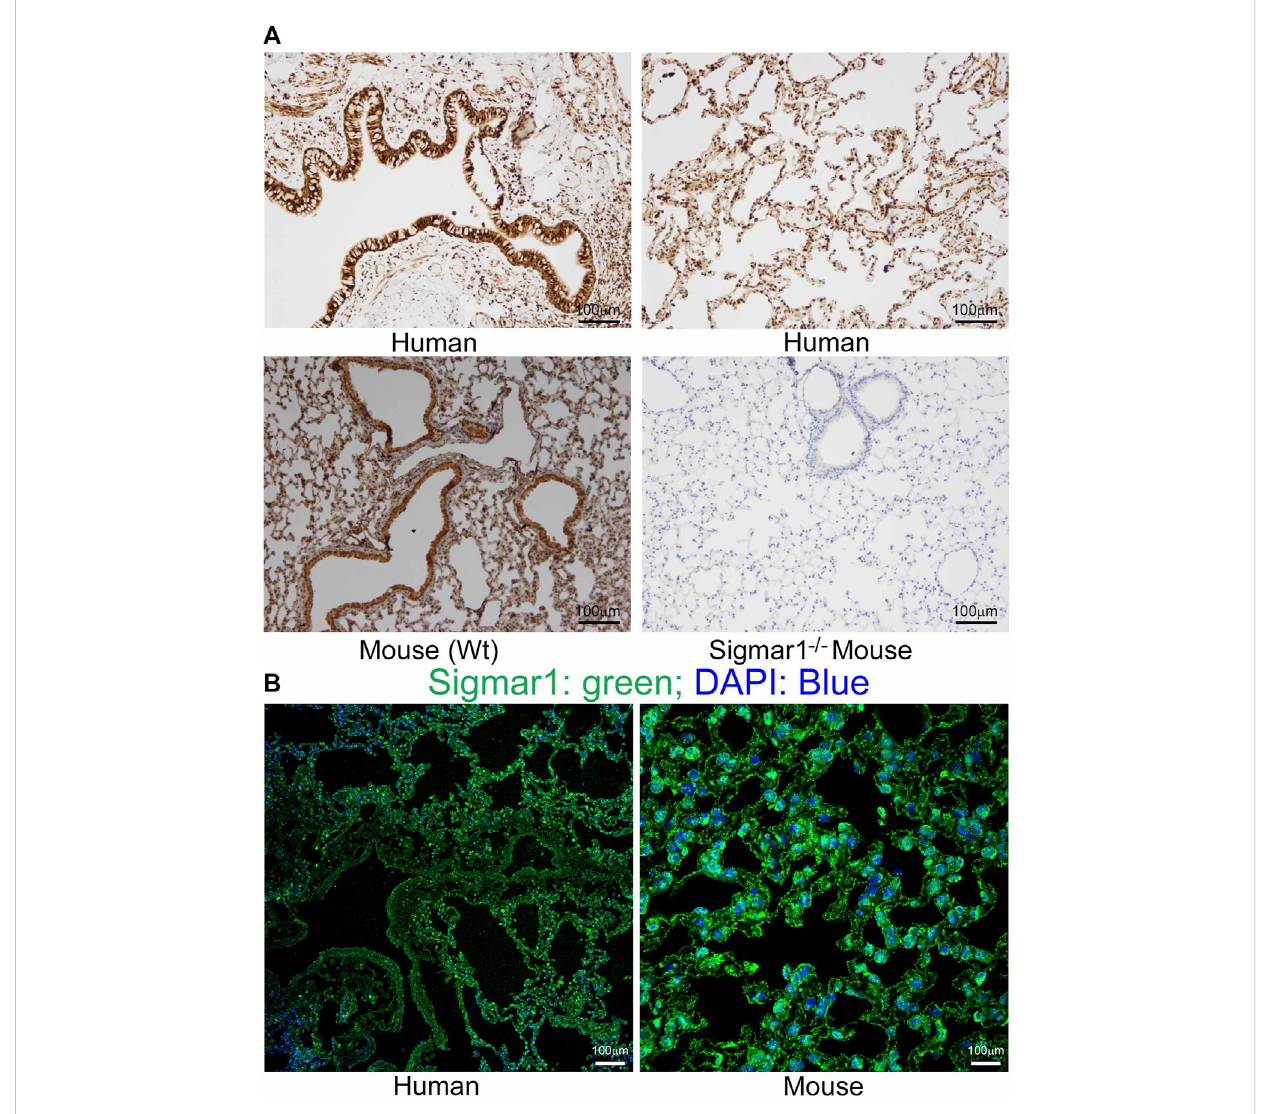
FIGURE 1 Sigmar1 is substantially expressed in human and mouse lungs. Paraf fi n- fi xed mouse and human lung tissue sections were stained for immunohistochemistry and immuno fl uorescence. (A) Representative images of immunohistochemical staining of human and mouse lung tissue sectionswithanti-Sigmar1antibodyshowedthesubstantialexpressionofSigmar1inthelungtissues.ImmunohistochemicalstainingofSigmar1 − / − mouse lung was used as a negative control for anti-Sigmar1 antibody and con fi rmed antibody speci fi city. (B) Immuno fl uorescence images showed human andmouselungtissuesectionsstainedforSigmar1antibody(green)andcounterstainedforDAPIasanuclearstain(blue).Imagesrepresenttwobiological replicates, and 10 to 12 microscopic fi elds were analyzed. Scale bars: 100